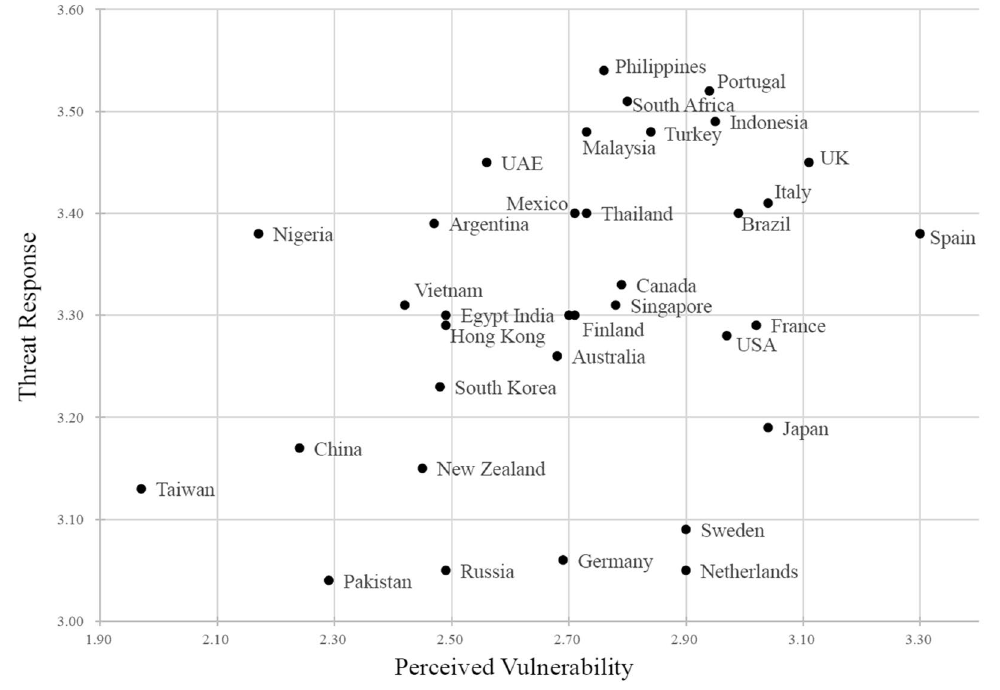
Figure 1. The country/society means of perceived vulnerability and threat response.